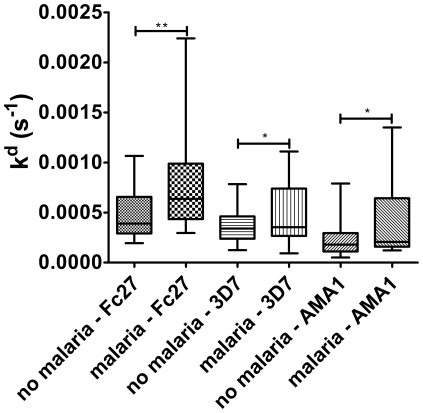
Association between affinity (measured as kd) and protection from clinical malaria.Affinity versus protection for the individuals in the Tanzanian population that were P. falciparum positive (n = 77). Individuals with high affinity had lower risk of developing malaria during follow-up (No malaria = did not get malaria within 40 weeks, Malaria = Experienced a clinical episode of malaria during follow up). Fc27 and 3D7 indicates the recombinant MSP2 proteins used in the SPR assay. (Box plots representations as in Figure 2.)